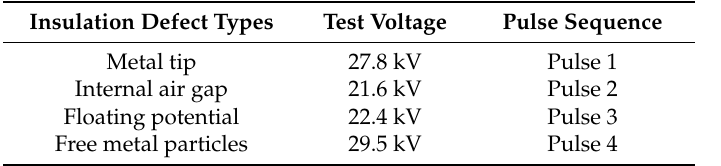
Table 1. Insulation defects and test voltages.